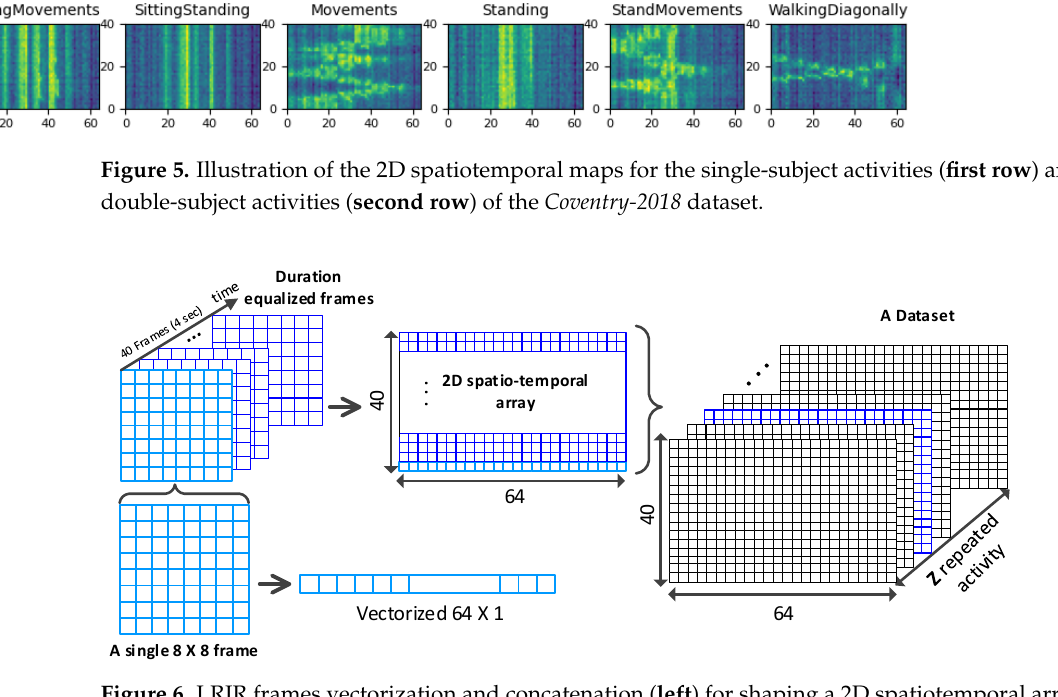
Figure 6. LRIR frames vectorization and concatenation ( left ) for shaping a 2D spatiotemporal array per activity ( middle ) and stacking all 2D maps for all activities in the dataset ( right